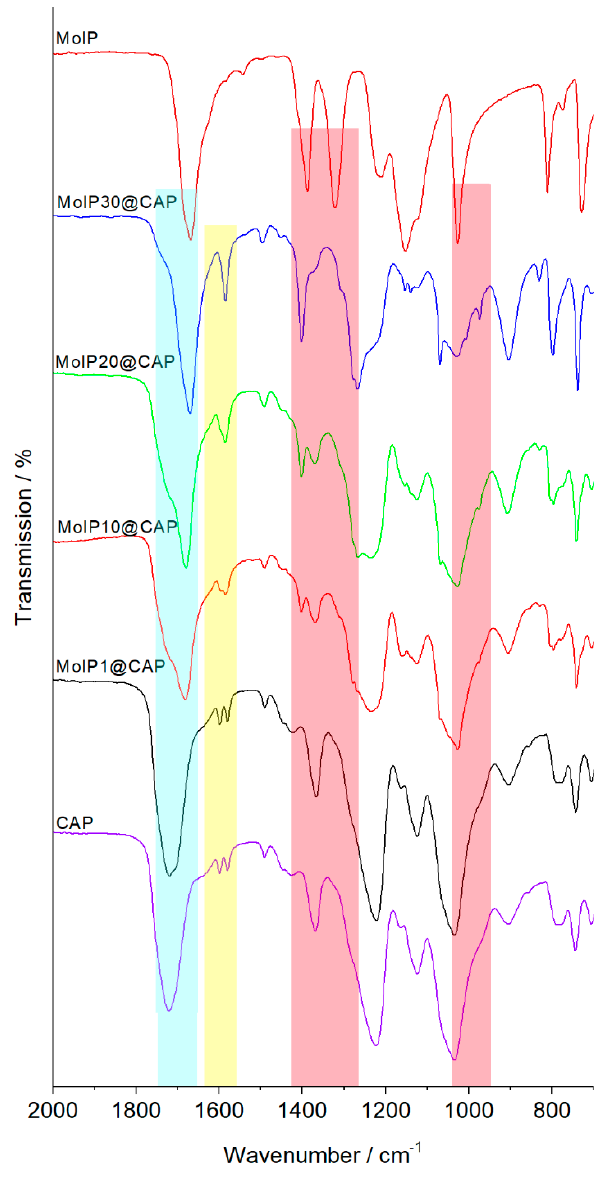
Figure 2. Infrared spectra of neat CAP , neat MoIP, and hybrid composite MoIPx@CAP films. The highlighted bands are the ones discussed.